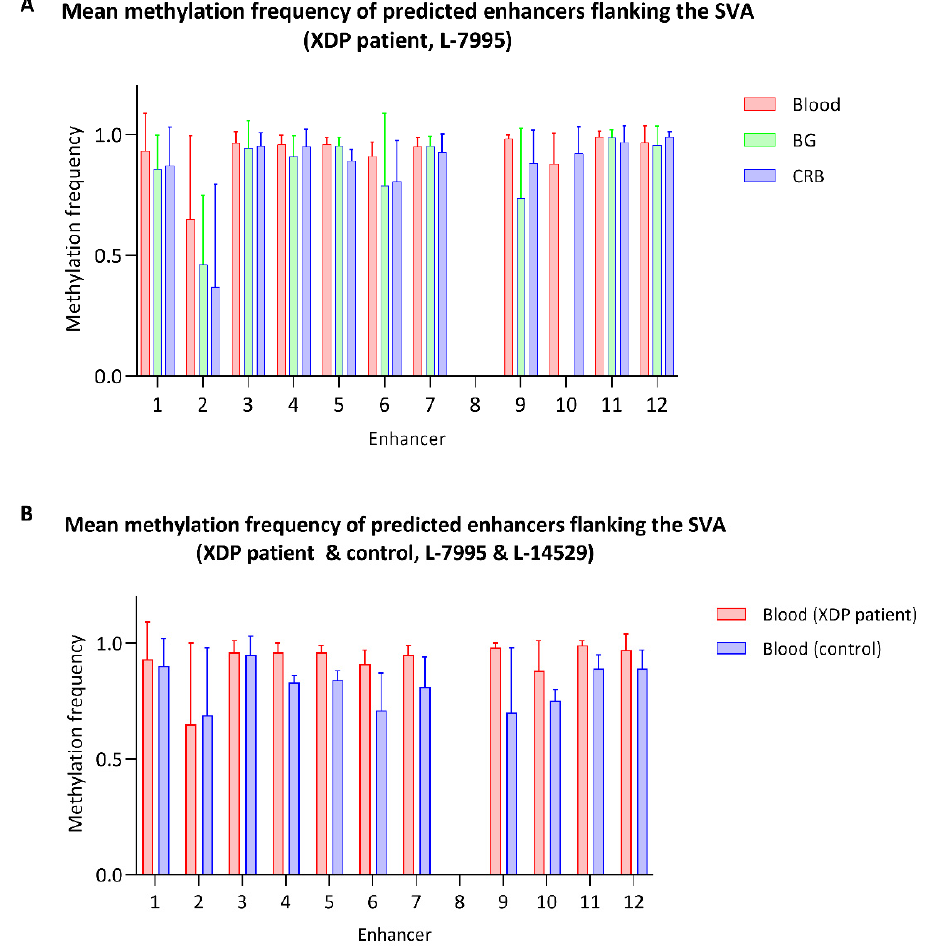
Figure 4. Methylation levels of the predicted enhancers flanking the TAF1 SVA. ( A ) The bar plot shows the CpG methylation frequency of predicted enhancer sites within the targeted region. DNA was derived from the blood, basal ganglia and cerebellum of a XDP patient ( A ) or derived from the blood of a patient and a healthy control participant ( B ). The bars and whiskers represent the mean and upper limit of the standard deviation of the methylation frequency from the CpG sites within a predicted enhancer.